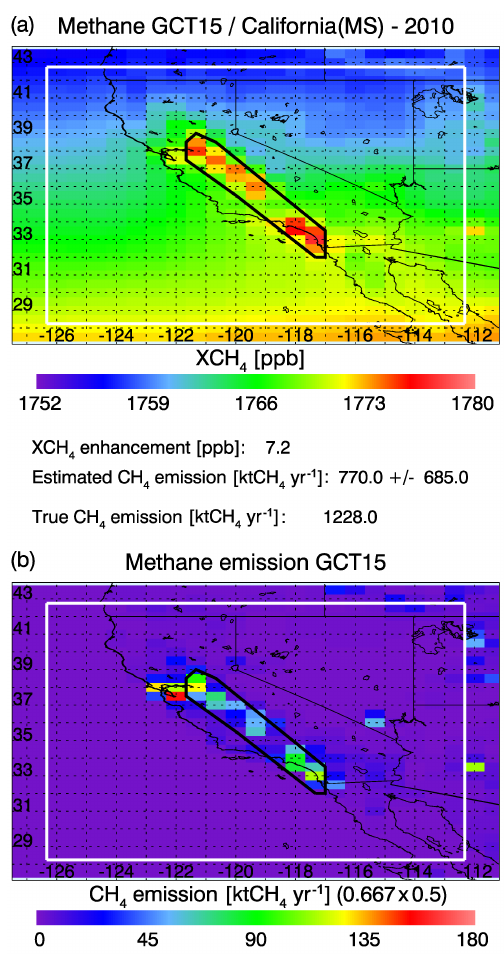
Figure 10. As Fig. 9 but for a larger part of California, referred to as California Mid/South (CMS) in this publication.